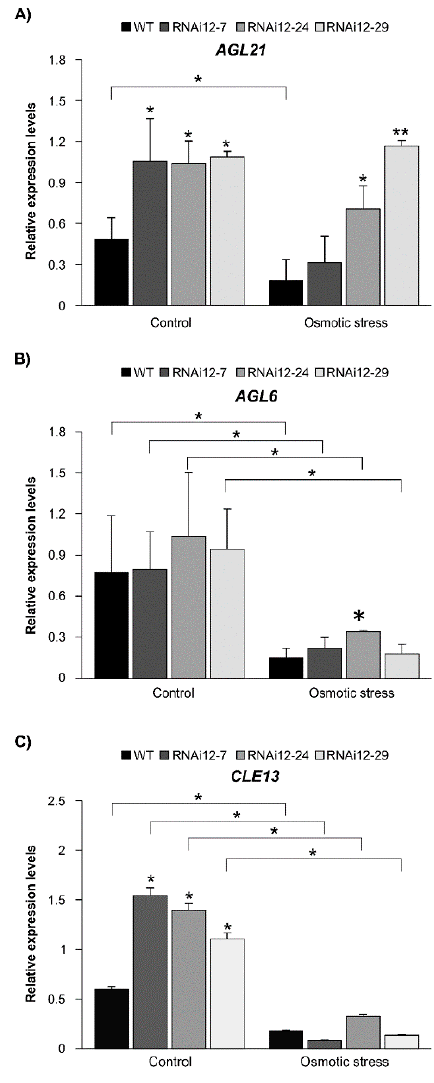
Figure 7. Effect of osmotic stress on transcript levels of AGL6 , AGL21, and CLE13 in WT and SPL12 - RNAi alfalfa. ( A ) AGL21 , ( B ) AGL6, and ( C ) CLE13 . * and ** indicate significant differences relative to WT using Student’s t -test (n = 4) p < 0.05, p < 0.01, respectively. Error bar indicates standard devi- ation.